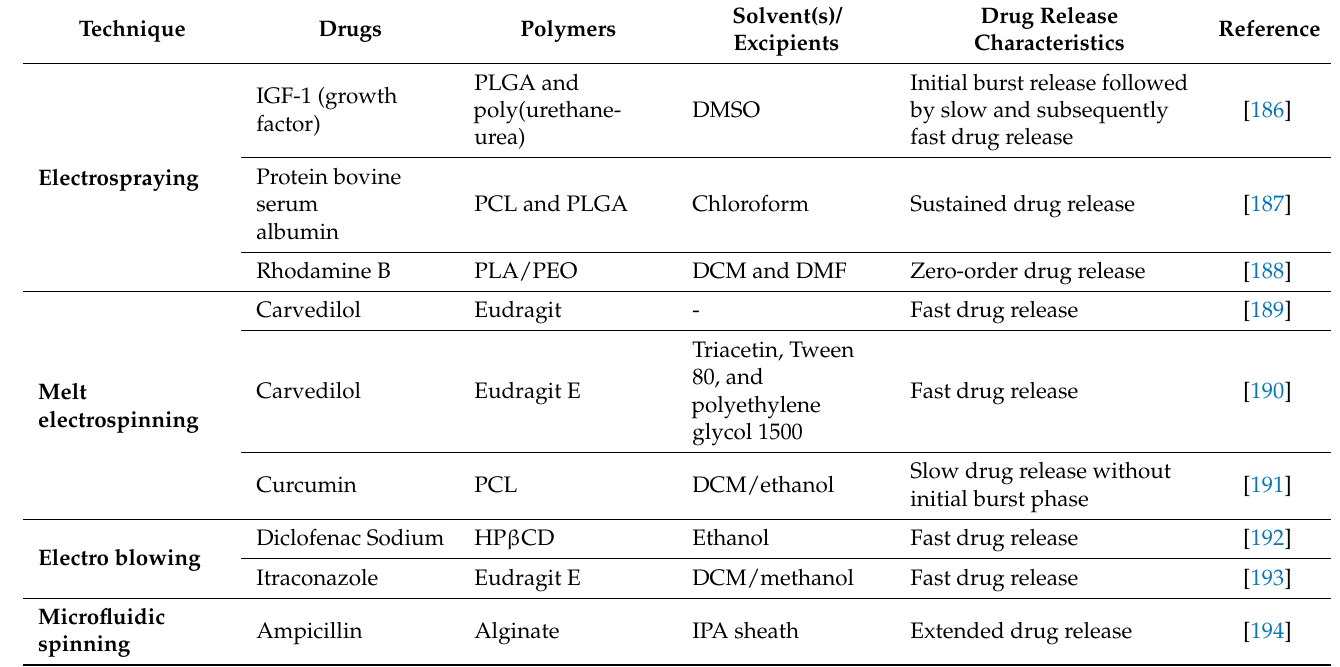
Table 12. Less commonly employed techniques for drug delivery